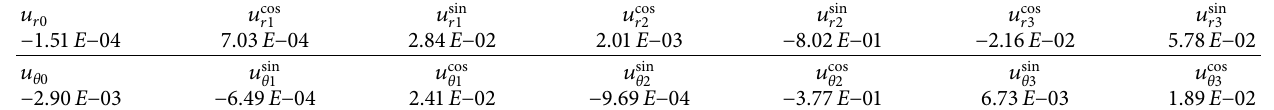
Table 4: Fitting results for the displacement parameters (units: mm).